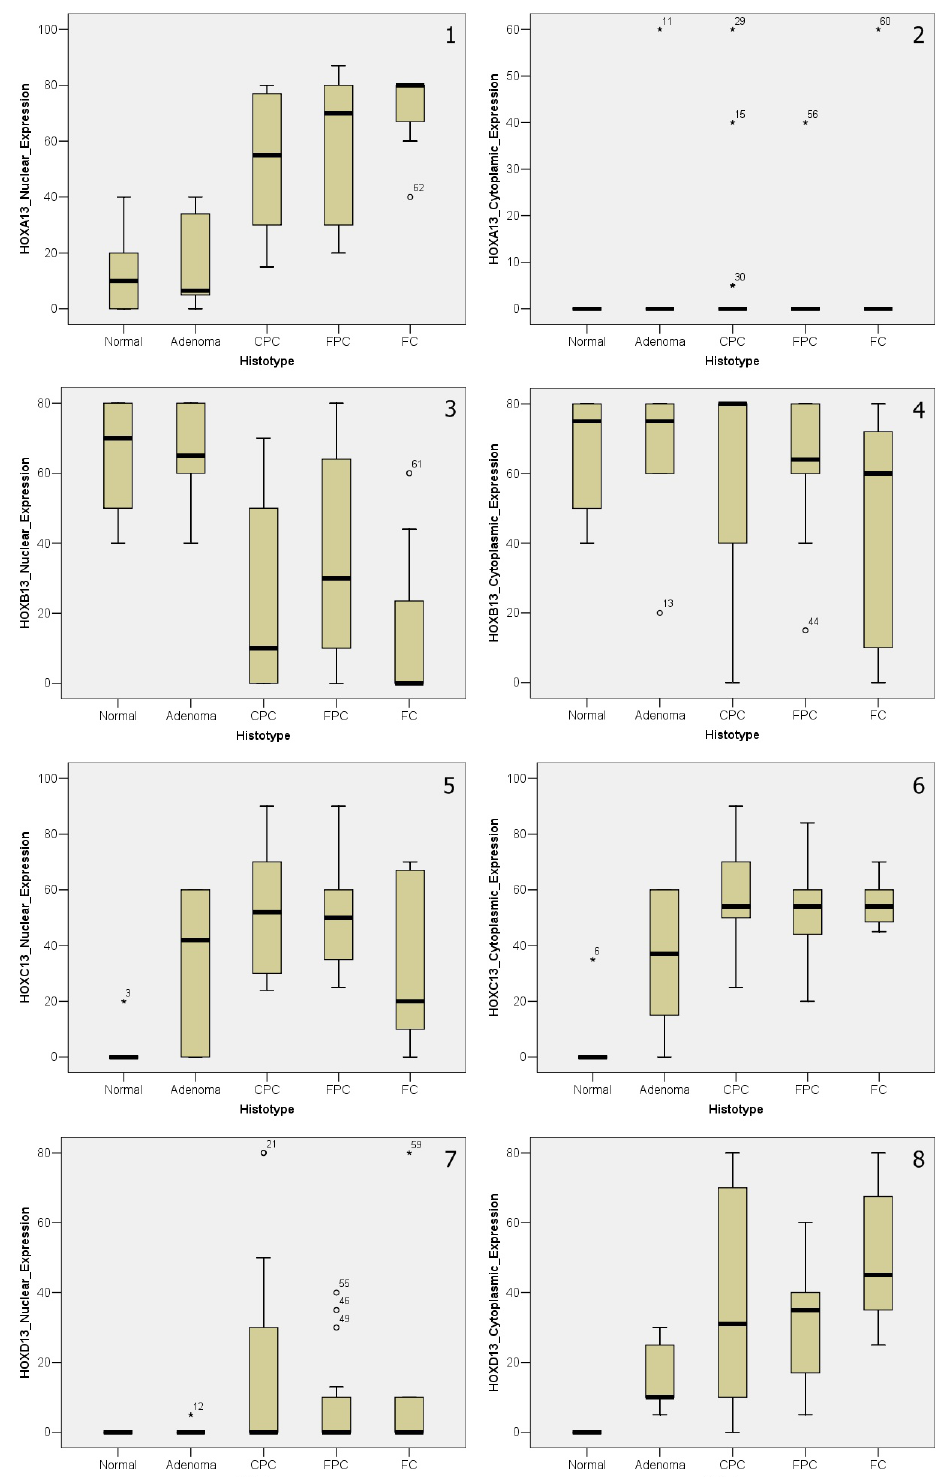
Figure 2. Plot graphic representation of paralogous group 13 HOX genes IHC expression in thyroid samples: ( 1 , 2 ) Nuclear (on the left ) and cytoplasmic (on the right ) HOX A13 expression; ( 3 , 4 ) Nuclear (on the left ) and cytoplasmic (on the right ) HOX B13 expression; ( 5 , 6 ) Nuclear (on the left ) and cytoplasmic (on the right ) HOX C13 expression; ( 7 , 8 ) Nuclear (on the left ) and cytoplasmic (on the right ) HOX D13 expression ( * and ° indicate values off the graph )